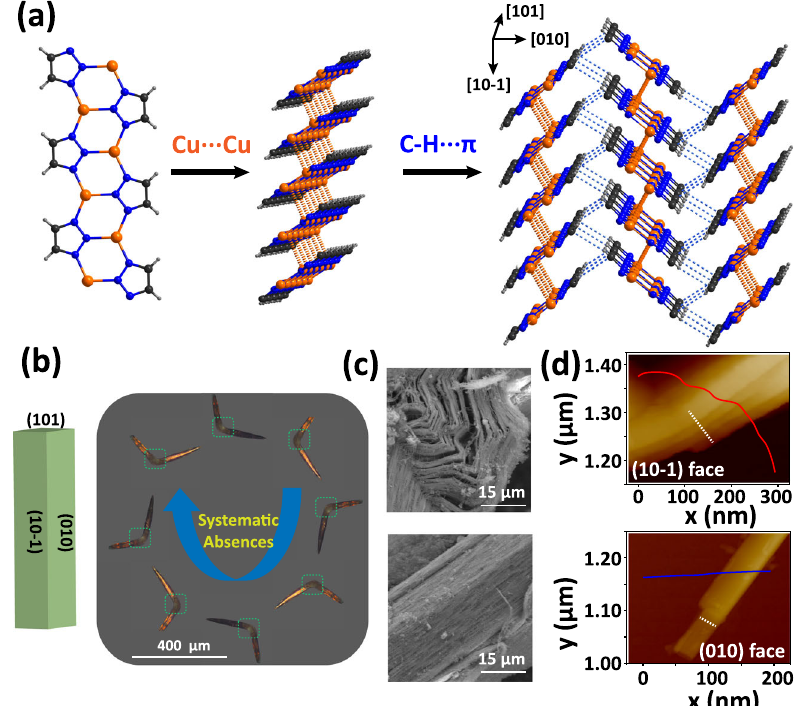
Fig. 1 | Crystal structures and morphology of Cu-Trz. a Crystal structures of Cu- Trz. The blue lines represent the C – H··· π interactions and the orange dash lines represent the Cu···Cu interactions. Color scheme: C, black; N, blue; H, gray; Cu, orange. b Thecrystalfaceindexandthepolarizingmicroscopicimagesonthe(10-1)